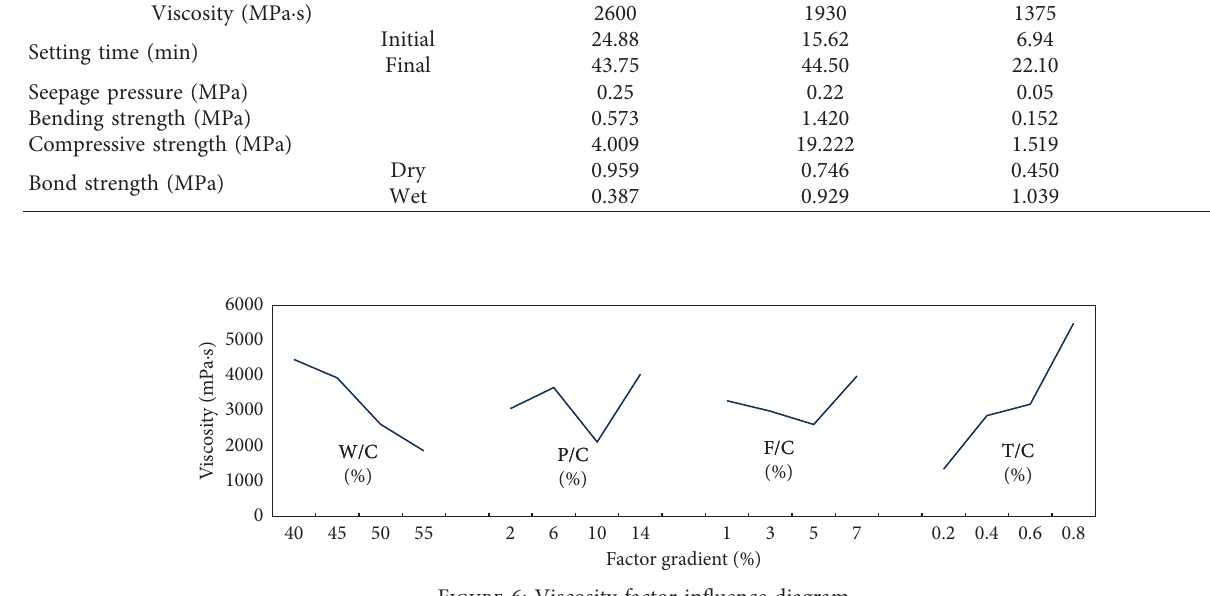
Figure 6: Viscosity factor influence diagram.